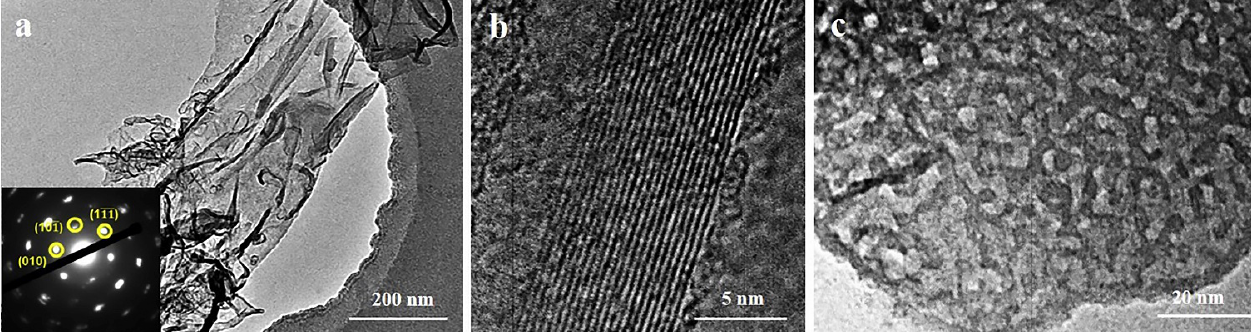
Figure 12. High-resolution transmission electron microscope (HRTEM) images of Mo 2 C MXene, showing ( a , b ) a layered structure and ( c ) a mesoporous surface. Reprinted with permission from [37] 2020 Elsevier.